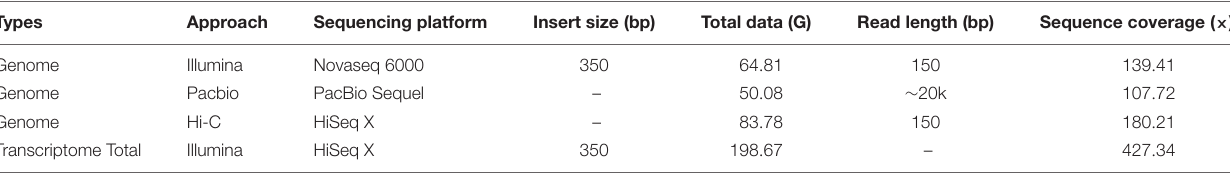
TABLE 1 | Statistics of the Bombyx mori sequencing data for genome assembly.